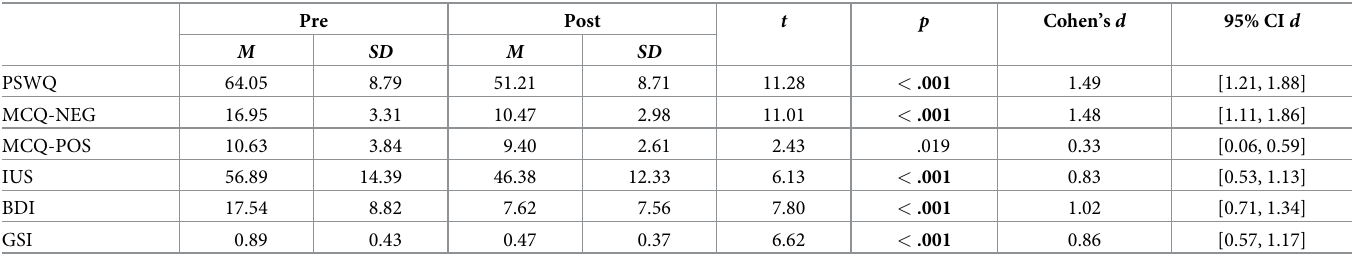
Table 2. Pooled imputed values: Means (M), standard deviations (SD), t-values, p-values, and effect sizes (d) at pre- and posttreatment.